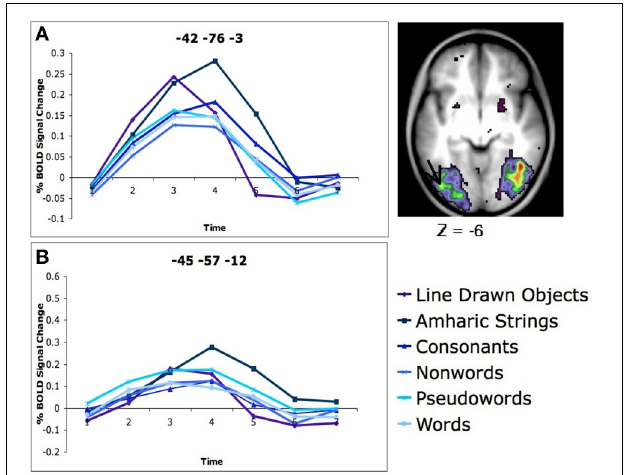
FIGURE 1 | There is more activity for Amharic character strings than letter strings in the left OT cortex. (A) Activity profile and location of region of the left OT cortex defined in a whole brain analysis of stimulus type. The location of the region closest to the VWFA is denoted with an arrow. The timecourses of BOLD activity for each stimulus type is shown for this region. (B) Timecourses of BOLD activity for each stimulus type in an region applied to the classic VWFA coordinates (coordinates in MNI, original Talaraich coordinates taken from Cohen and Dehaene, 2004). Figure adapted from Vogel et al.